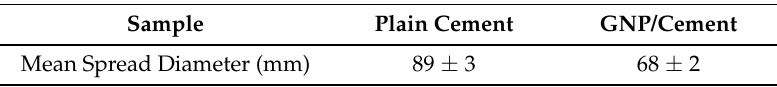
Table 1. Workability of the mixes.